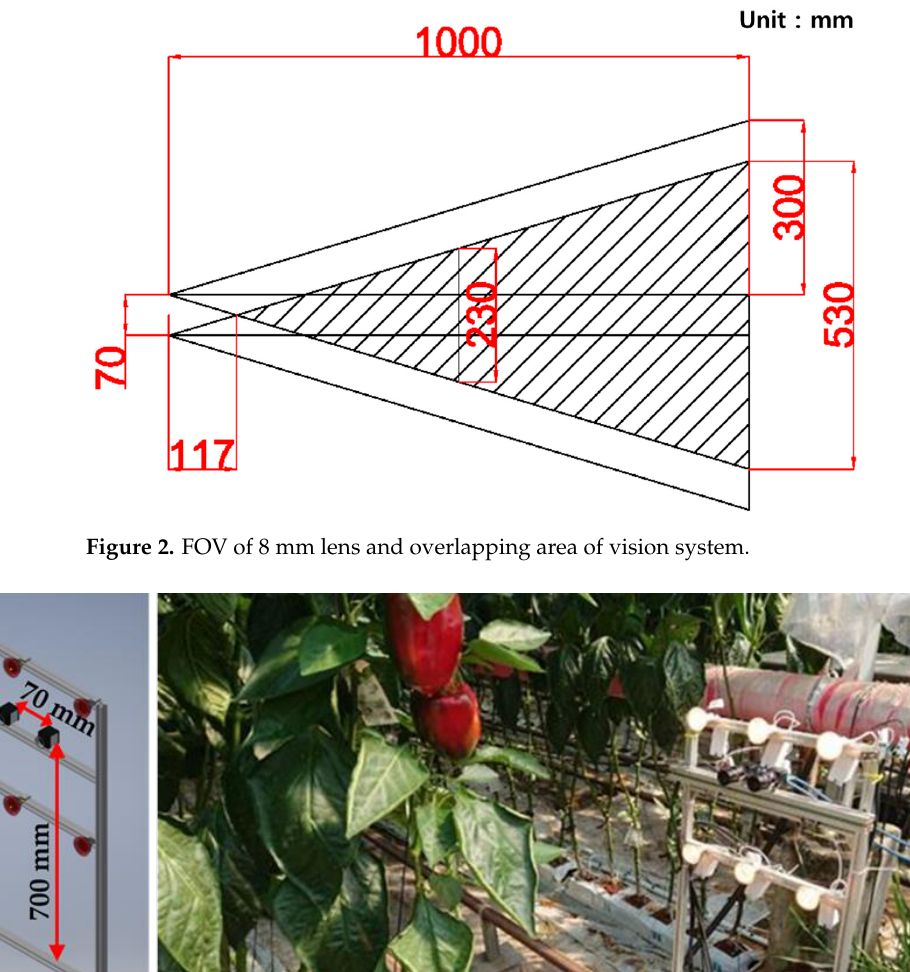
Figure 3. A structure for image acquisition ( a ) and image acquisition in the greenhouse ( b ).